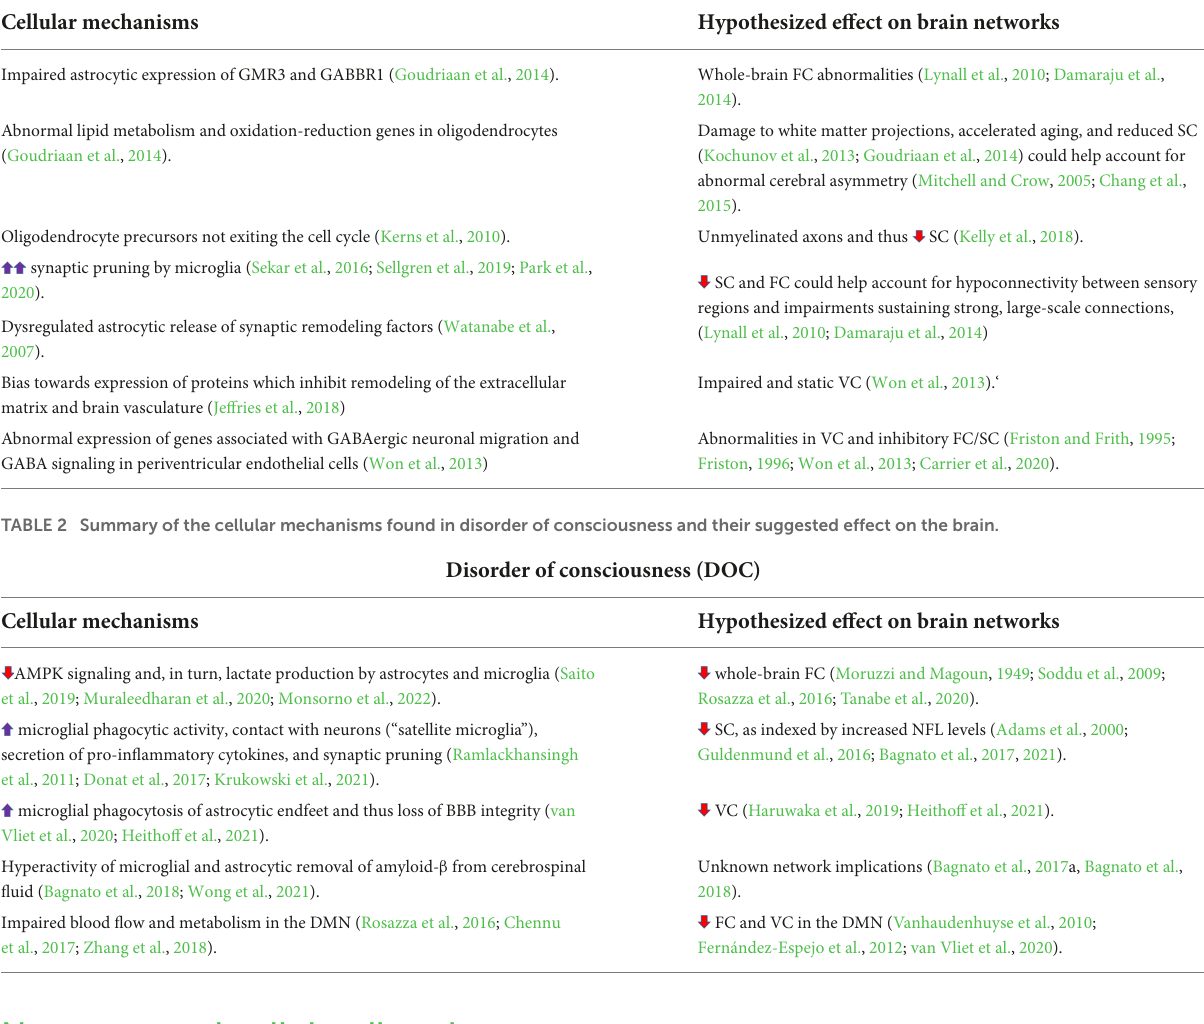
Schizophrenia (SCZ)